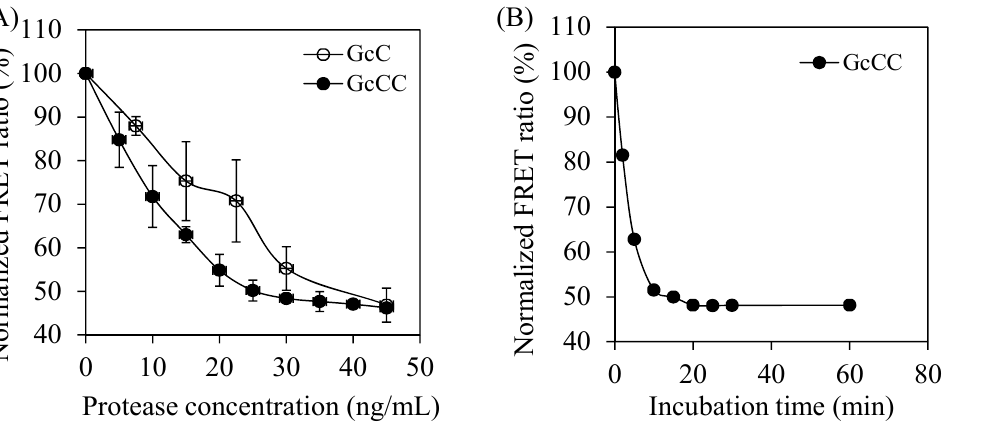
Figure 2. Characterization of the probes in vitro . ( A ) Effect of protease amount on the normalized FRET signal. 50 μ g/mL probe protein were incubated with HIV-1 protease for 1 h. ( B ) Protease cleavage kinetics. 40 ng/mL of protease and 50 μ g/mL of probe protein were used in the assays. Experiments were performed in triplicates. Symbols: GcC, a FRET probe with single acceptor protein; GcCC, a FRET probe with a tandem acceptor protein; Error bar: ±SD